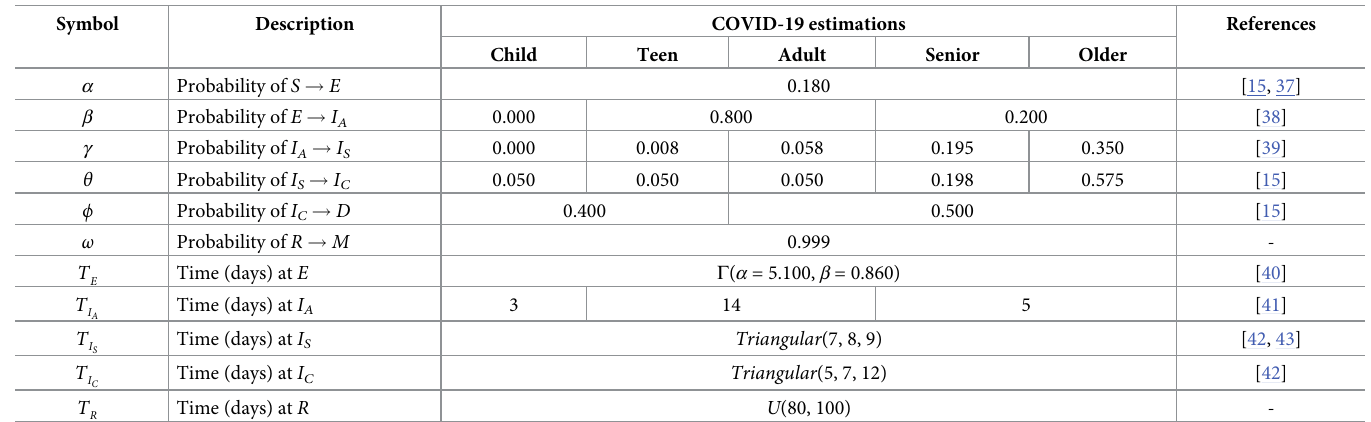
Table 4. Parameters of INFEKTA and their estimations for